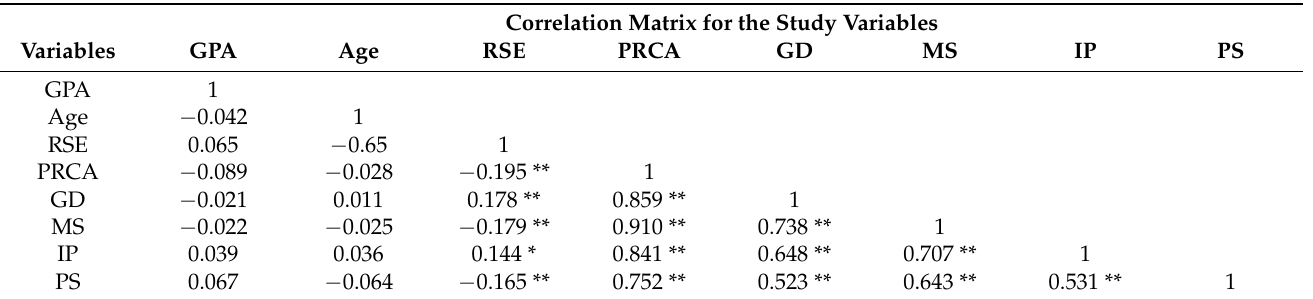
Table 6. Spearman Correlation between GPA with Rosenberg SES, Communication anxiety, GPA among study respondents. Correlation Matrix for the Study